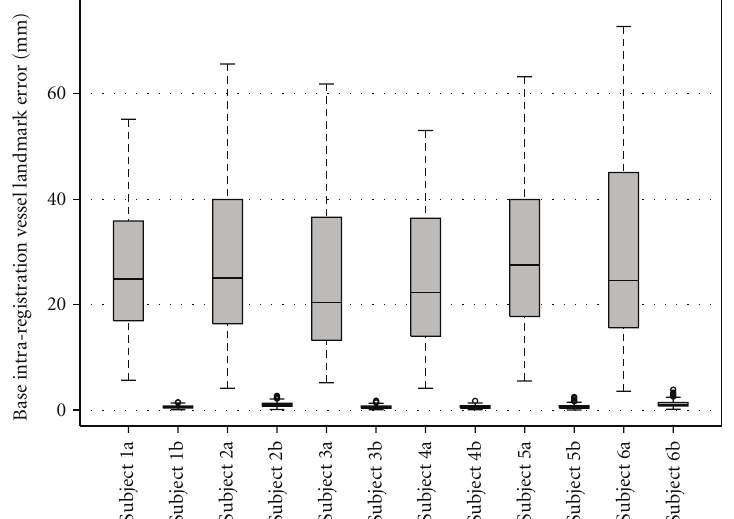
Figure 8: Registration accuracy on vessel landmarks of baseline intra-phase registration. For each subject, the left bar shows error before registration, and the right bar shows error after